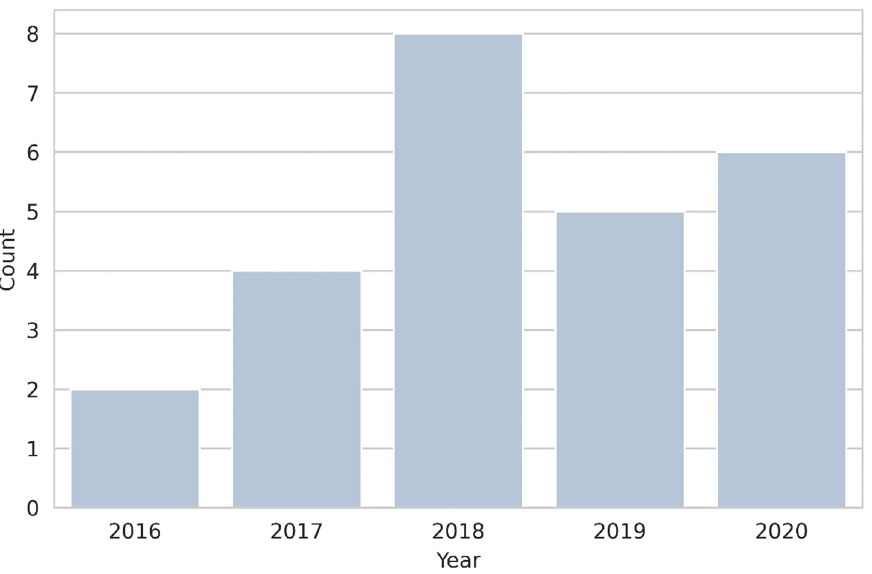
Figure 2. Count plot showing studies published per year.